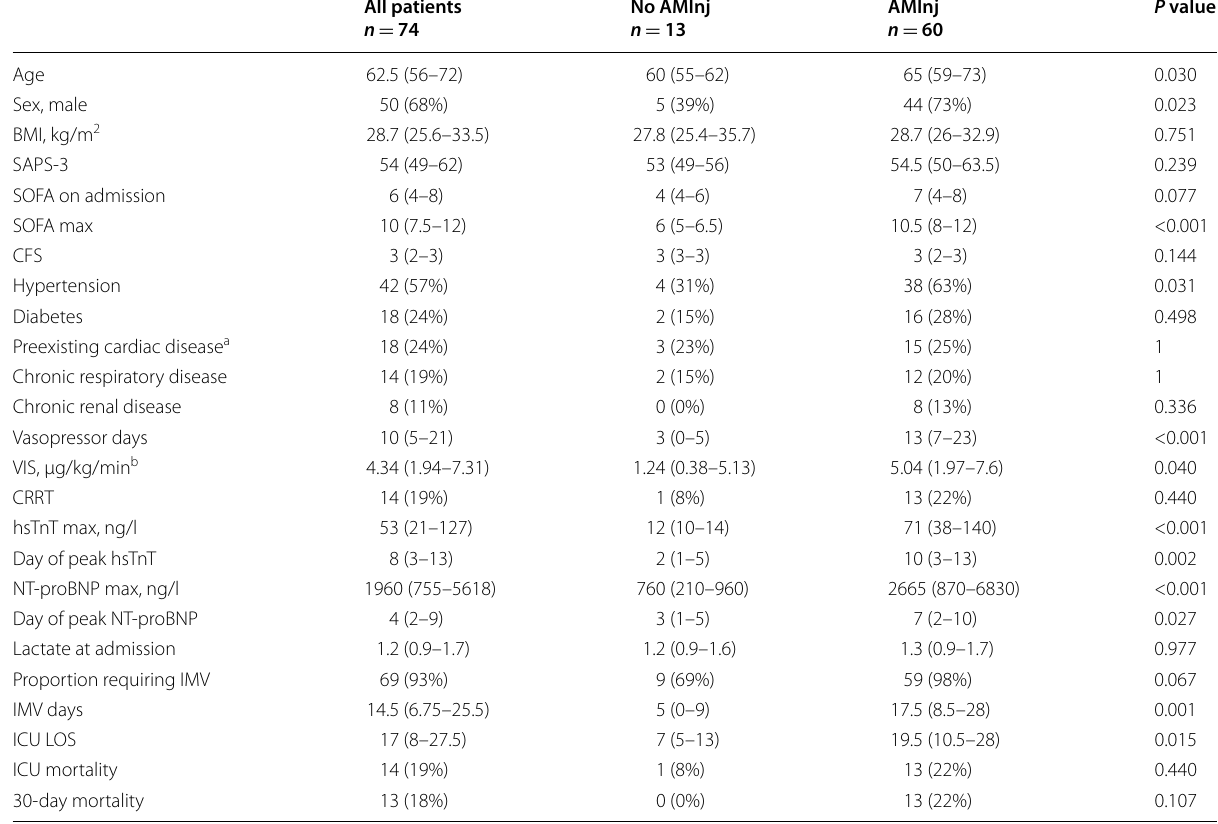
Acute myocardial injury (AMInj) is defined as an increased hsTnT > 14ng/L and a > 20% absolute change with or without ischaemic symptoms [1] Data are given as n (%) or median (IQR) unless otherwise